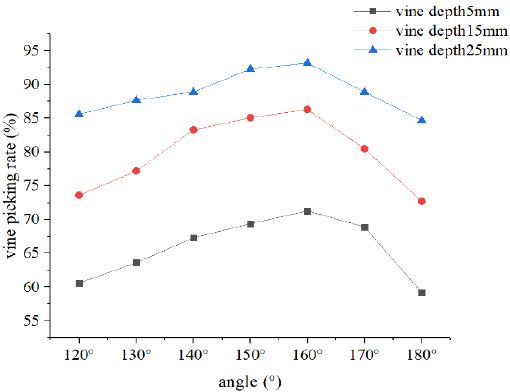
Figure 10. Variation curve of vine picking rate with end inclination at different vine depths.